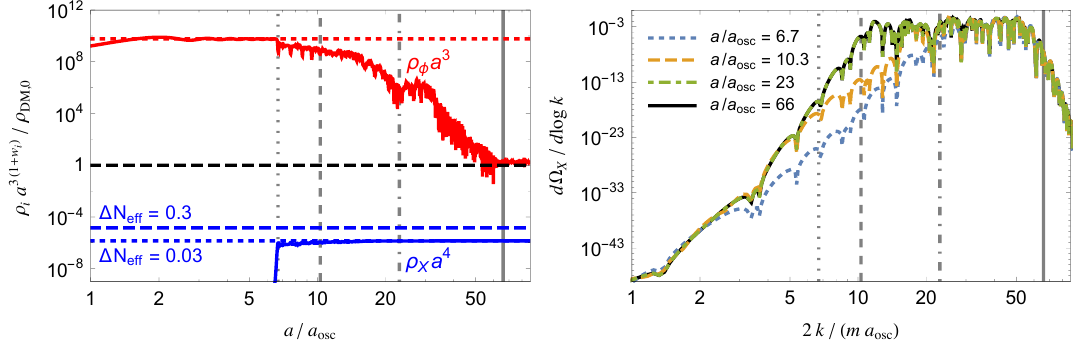
Figure 5 . Left: comoving energy densities normalized to the present time dark matter energy density with the scale factor normalized to unity at the present time. Right: dark photon power spectrum where the vertical gray lines show the position of the narrow resonance band k = ma= 2 for four di(cid:11)erent values of the scale factor. The line styles correspond to: Dotted: initial large energy drop, Dashed: tachyonic band closure as approximated by eq. (3.8), Dot Dashed: narrow parametric resonance band enters the most pumped part of the gauge power spectrum, Solid: narrow parametric resonance band leaves the most pumped part of the spectrum and energy transfer from the axion to dark photons ends when the scale factor is (cid:25) (cid:11)(cid:18) . The plots here use the ALP 2 model parameters as shown in table